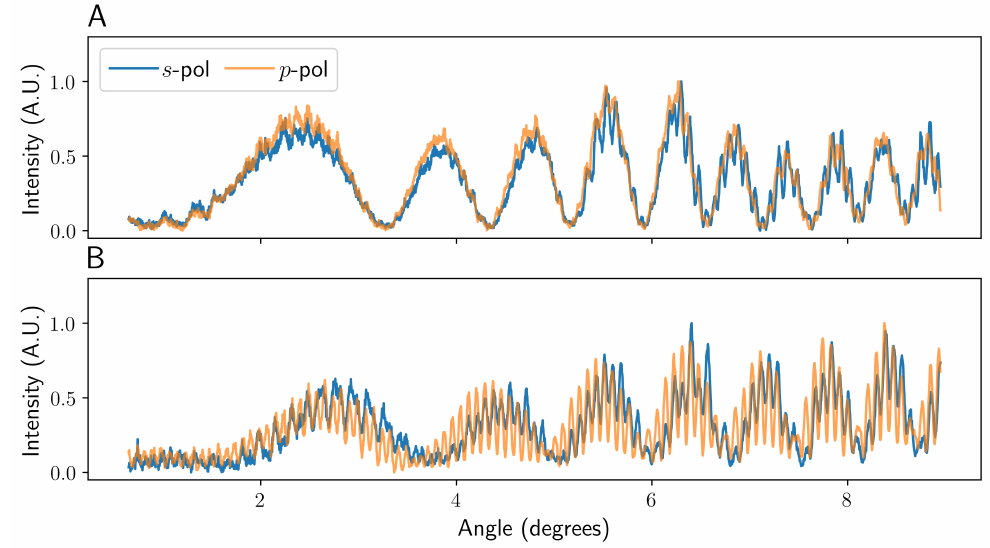
Figure 5. A figure showing the experimental intensity patterns seen for a capillary both higher ( A ) and lower ( B ) than the ρ = 1 limit. The data were taken at ∼ 9cm horizontally and ∼ 0.75cm vertically from the capillary, with a camera width of 1.3cm. The data were longitudinally averaged to reduce high-frequency noise and produce a more representative fringe pattern [13]. The data have been normalised between 0 and 1 to aid